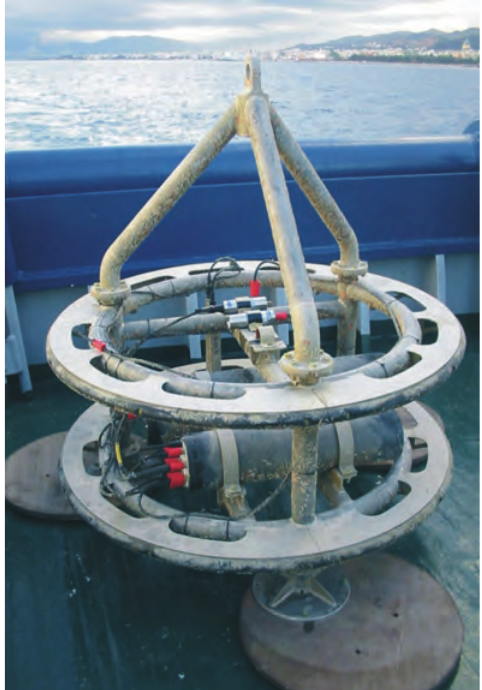
Fig. 7. GMM module on the ship before the de- ployment in the Corinth